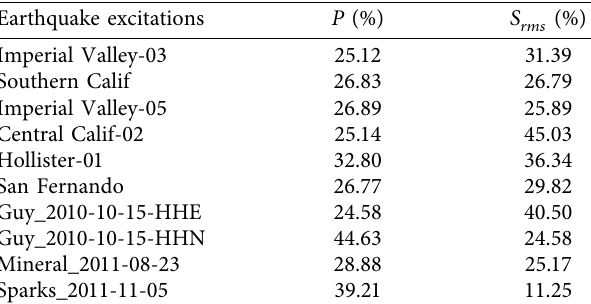
Table 6: Vibration reduction ratio of NSBD to frame structure under diferent earthquake